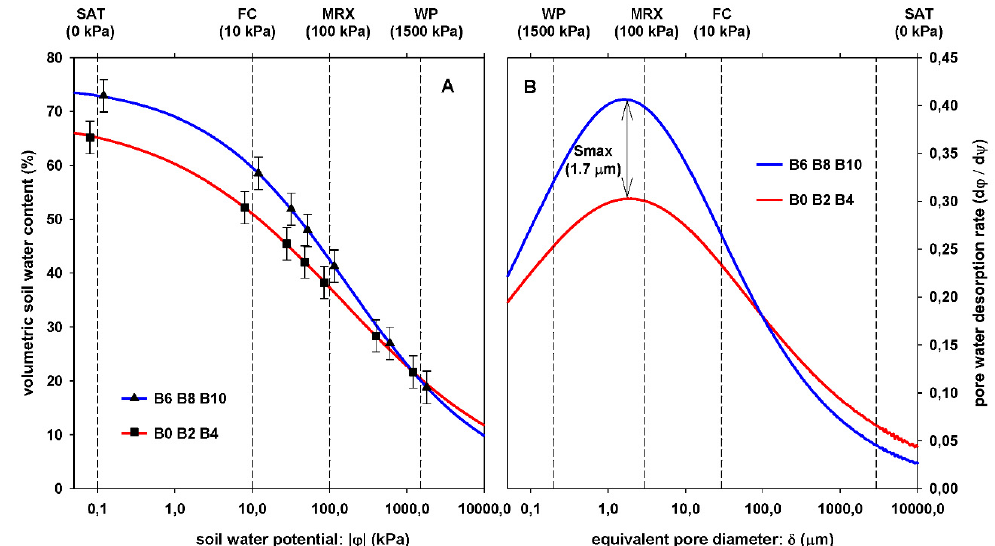
Figure 5. ( A ) Desorption curves of the two statistically different treatment clusters (B0, B2 and B4) vs. (B6, B8 and B10) according to the van Genuchten model. ( B ) pore size distribution functions of the same former curves, obtained by calculating their slope (first derivative d θ /d ψ ) and plotting the data on an x -axis where soil water potential values were converted into pore equivalent diameter .